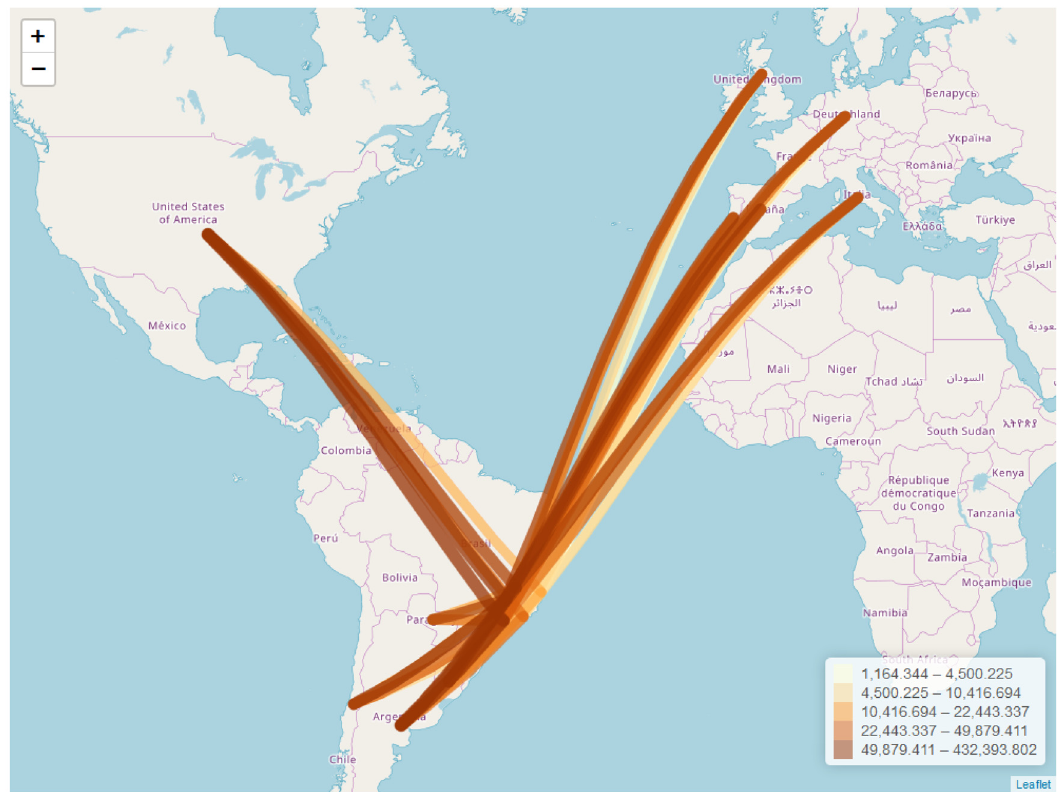
Figure 2. Population flows between Brazil states and other locations plotted using type = "map" .